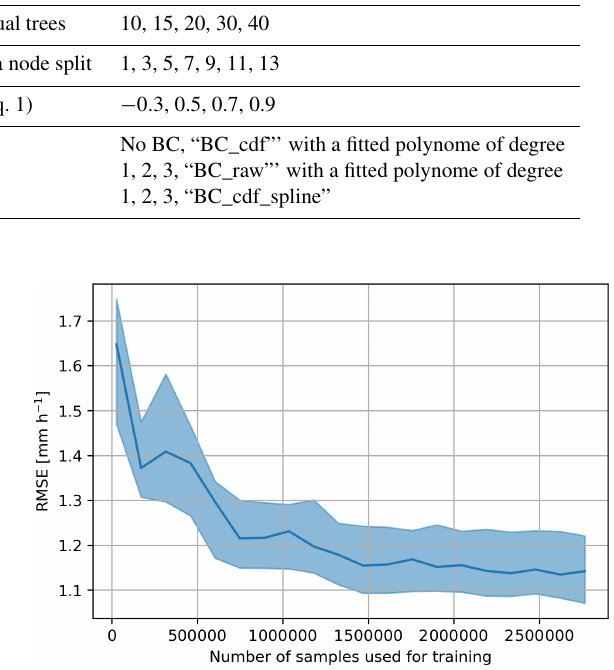
Figure 6. Learning curve of the RF_dualpol model. It shows the RMSE of the test fraction at hourly scale as a function of the num- ber of samples used for training. The curve was obtained with 10 iterations of a five-fold cross-validation. The colored areas corre- spond to the Q25–Q75 interquantile and the solid line to the mean.